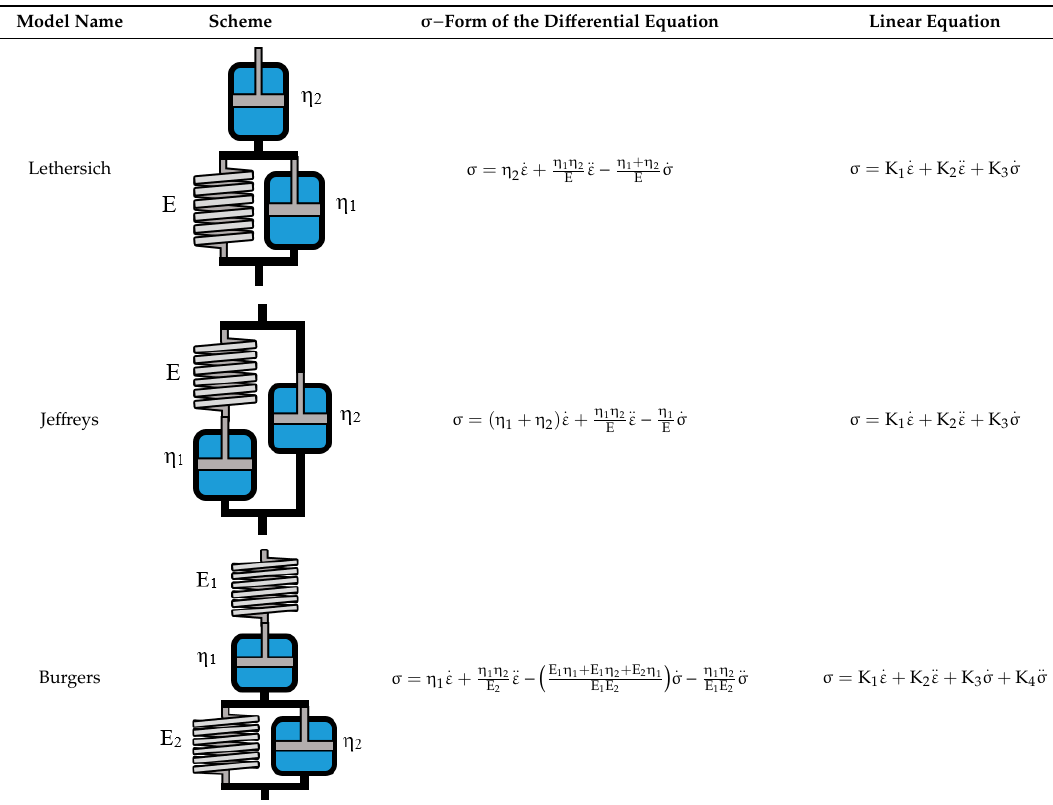
Table 3. Overview of rheological models with constitutive equations of second order differential equation type, having 3 or 4 main effects Ki.